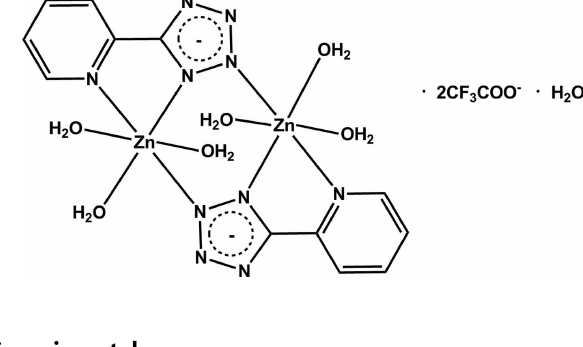
Key indicators: single-crystal X-ray study; T = 298 K; mean (cid:2) (C–C) = 0.004 A˚; disorder in solvent or counterion; R factor = 0.041; wR factor = 0.089; data-to- parameter ratio = 12.6.